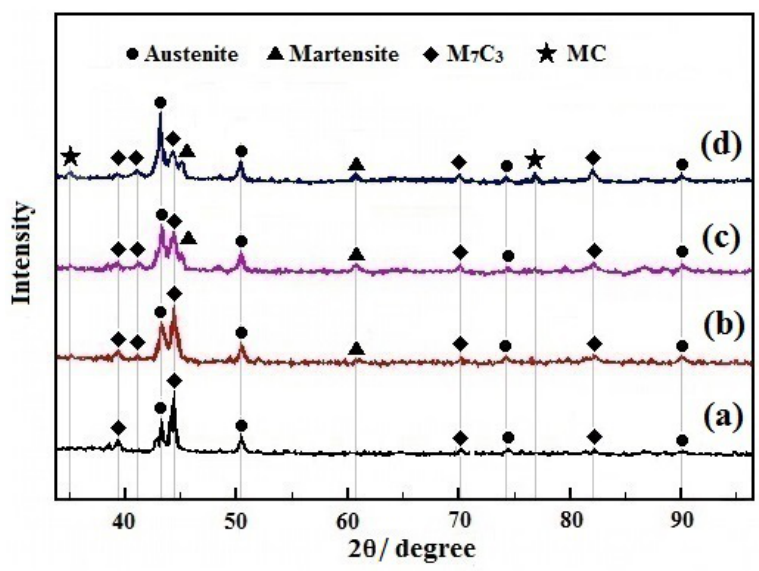
Figure 7. XRD of the hardfacing layer with different V contents, (a) 0 V, (b) 0.83 V, (c) 1.50 V, (d) 2.32 V.